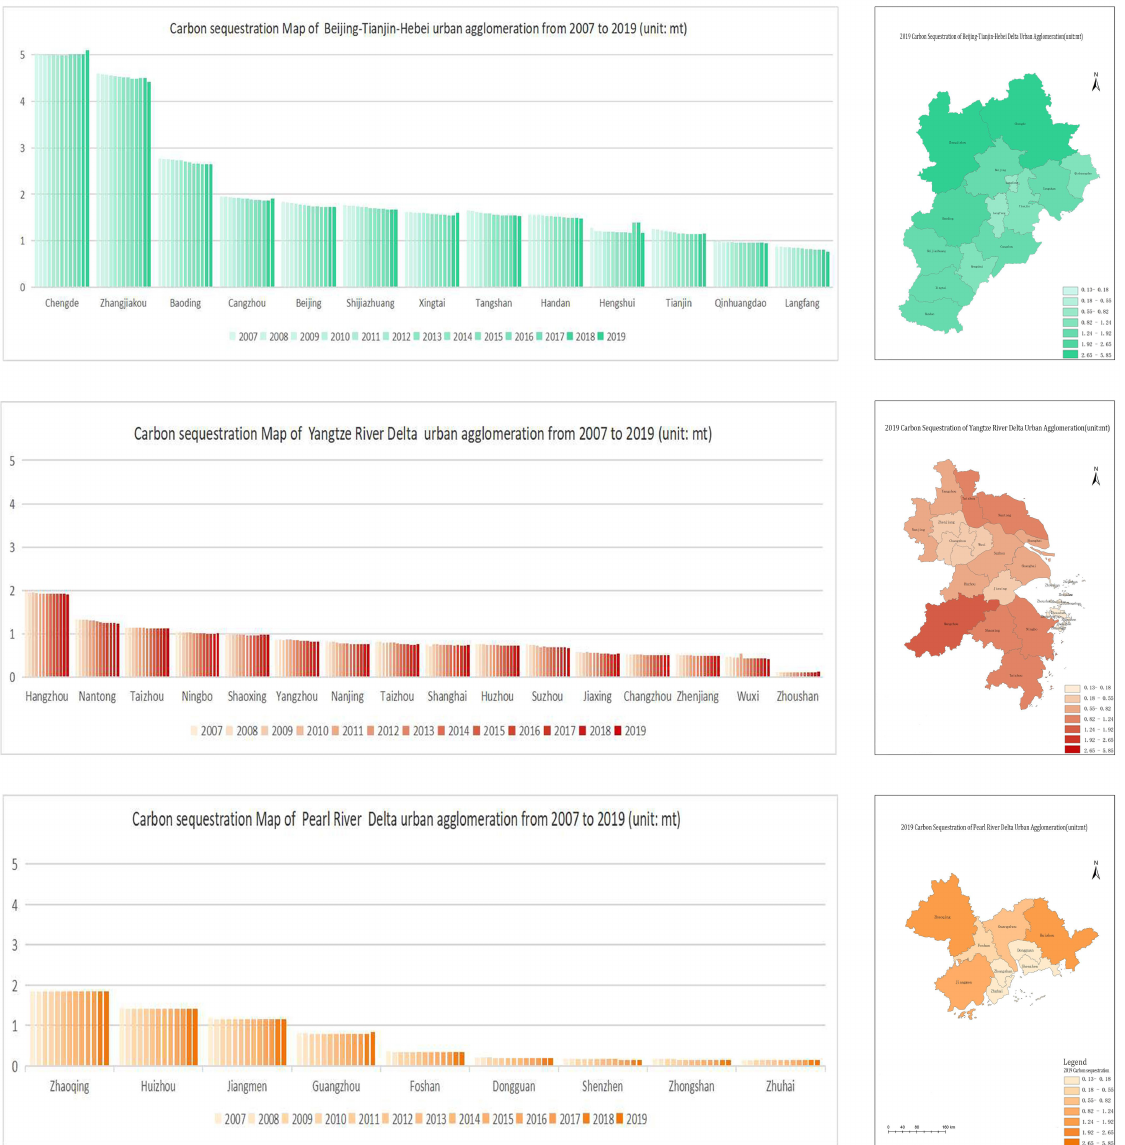
Figure 3. The carbon sequestration of the three major UAs from 2007 to